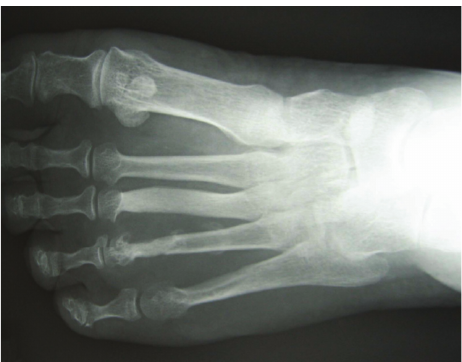
Figure 1: Plain radiograph at admission.